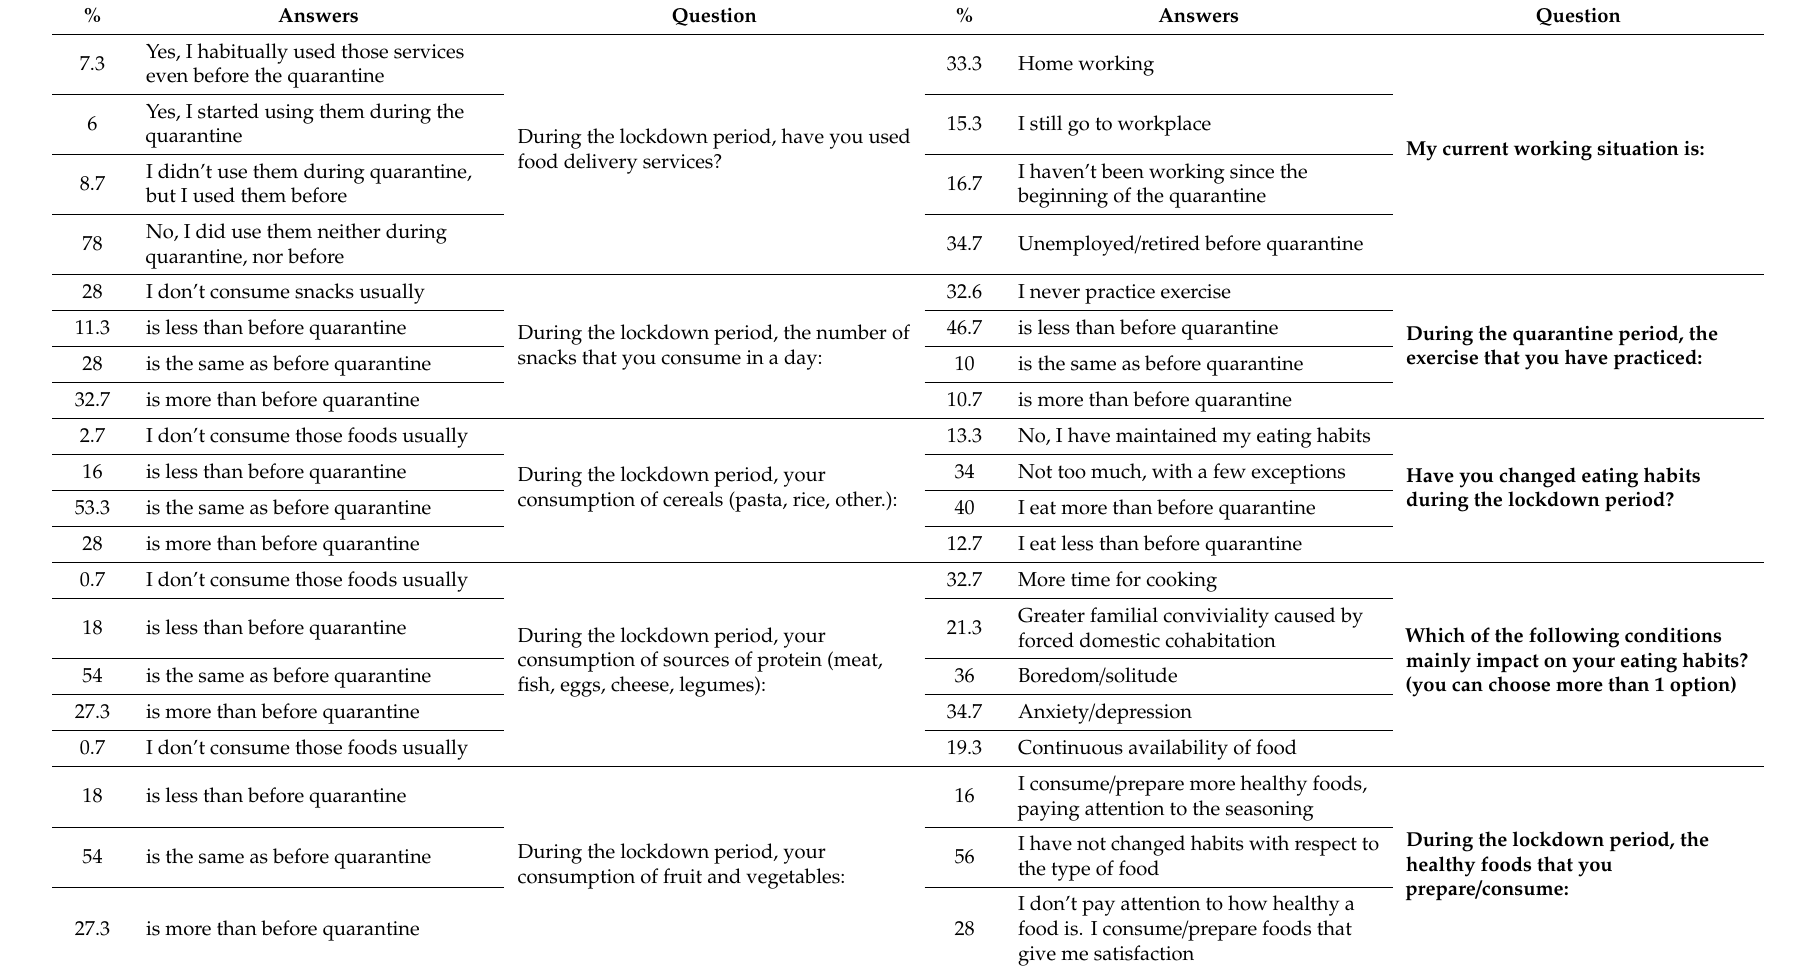
Table 2. Answers to the Questions of the